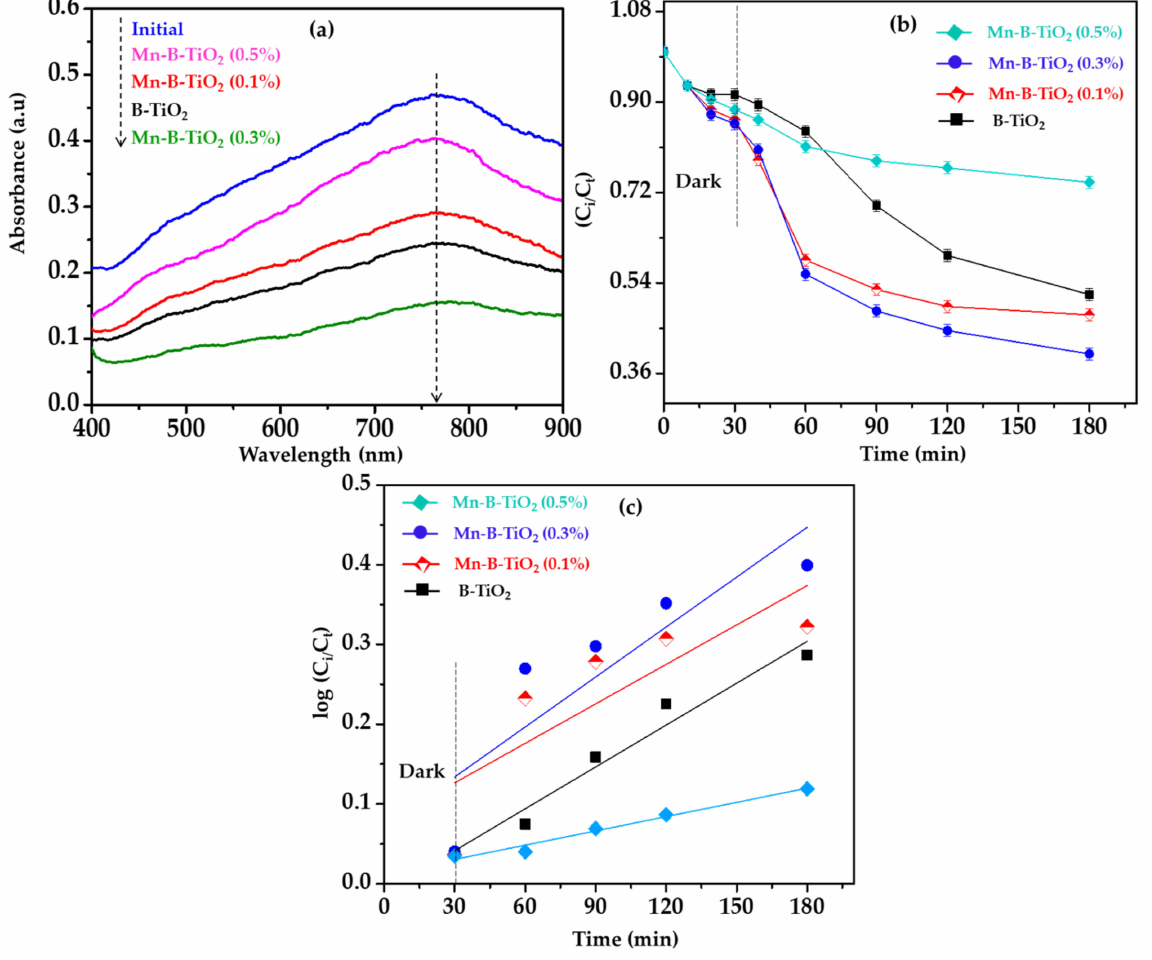
Figure 7. ( a ) UV-Vis absorbance spectra of TPOME after treatment (b) photocatalytic performance of B-TiO 2 and Mn-B-TiO 2 NPs for phenols’ removal and ( c ) kinetic plots of photocatalytic phenols’